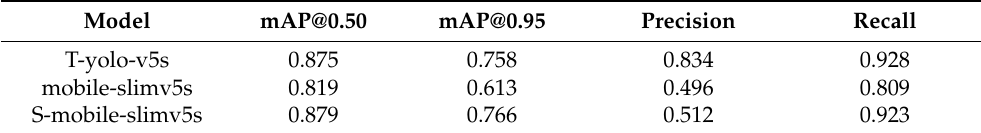
Table 6. Performance comparison of models when the input dataset is Dataset(S).